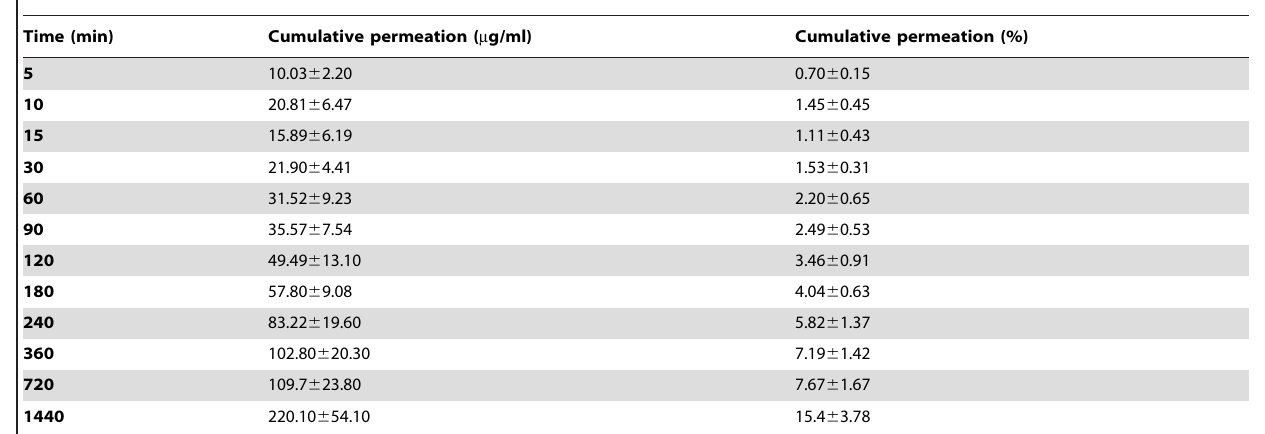
Table 9. Permeation of BSA from SA MNs across dermatomed human skin, where the results were obtained using the BCA method (means 6 SD, N= 3, each data point represents the average of four replicates for each of the 3 different polymeric microneedle